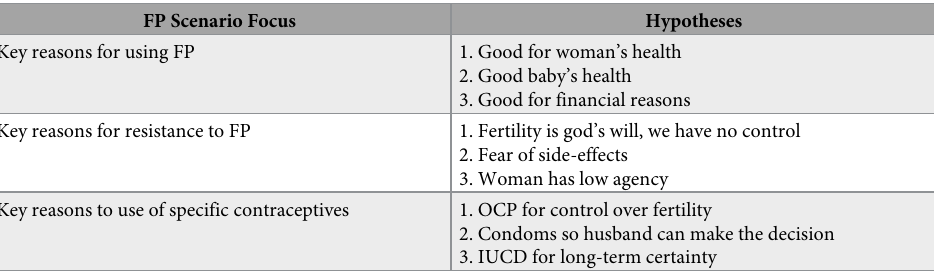
Table 3. Drivers of FP assessed in decision